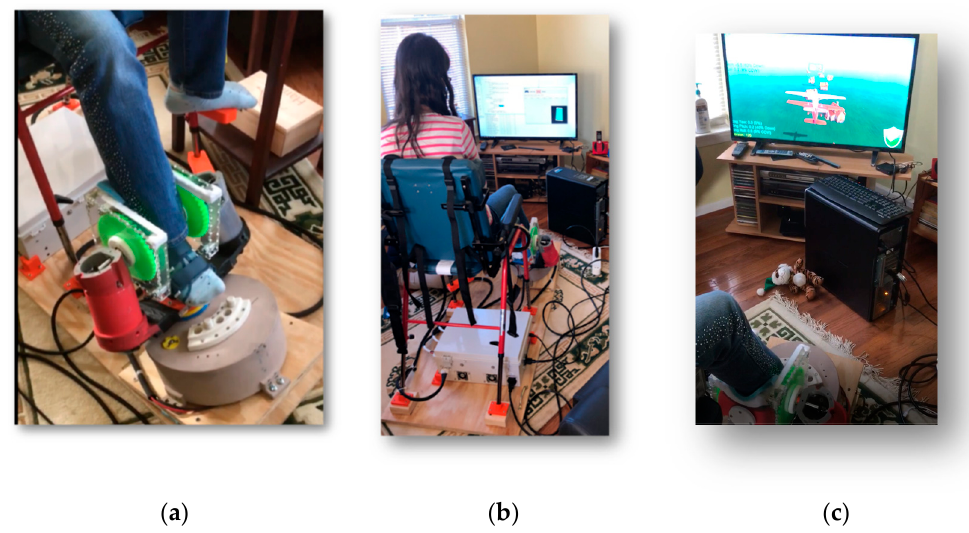
Figure 2. PedBotHome prototype in pilot use in a participant’s home. ( a ) Child’s foot in the robot-assisted controller; ( b ) PedBotHome prototype footprint; ( c ) Flying game interface.